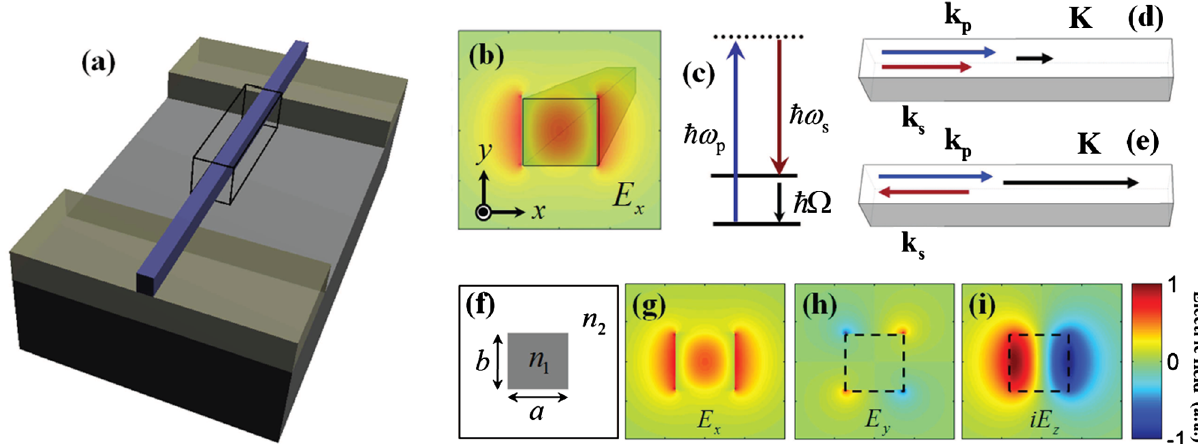
FIG. 1. (a) Sketch showing one experimental embodiment of a suspended silicon waveguide. The black wire-frame represents the portion of the waveguide examined here. (b) The cross-sectional sketch of the waveguide within the wire-framed region with the E field of fundamental TE-like mode superposed. (c) The energy-level diagram of a Brillouin process. Here the optical pump and Stokes waves are shown in blue and red, respectively, while the phonon is shown in black. Phase-matching diagrams for forward (d) and backward (e) SBS. (f) The waveguide cross section (f) along with mode profiles for the (g) E fundamental TE-like mode for (cid:2) ¼ 1550 nms , a ¼ 300 nm , and b ¼ 280 nm